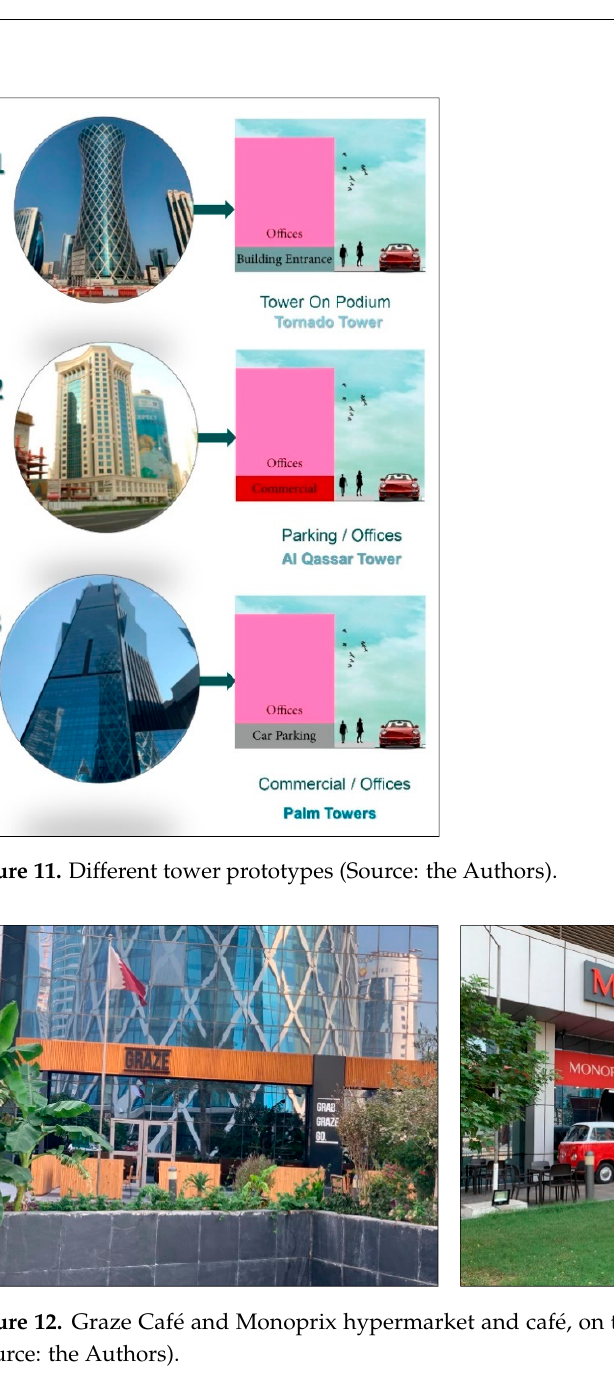
Figure 12. Graze Café and Monoprix hypermarket and café, on the ground floor of Palm Towers (Source: the Authors).